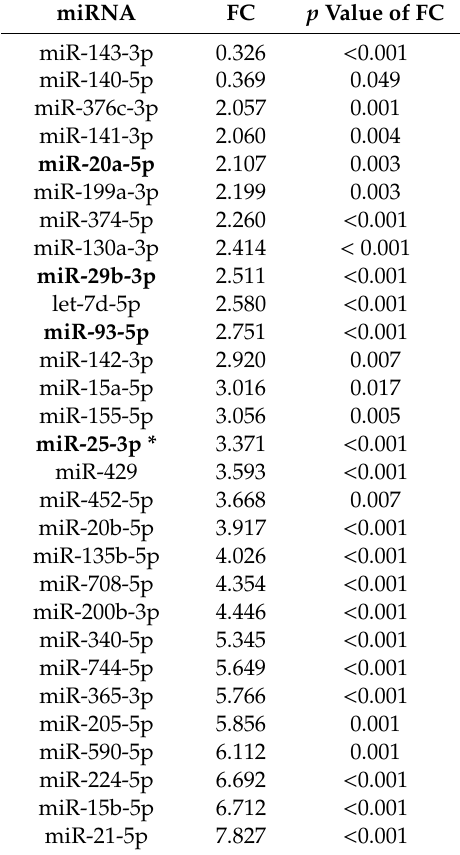
Table 2. Significantly deregulated miRNAs in NSCLC, sorted based on fold change (FC) values, from lower to higher. miRNA FC p Value of FC miR-143-3p 0.326 < 0.001